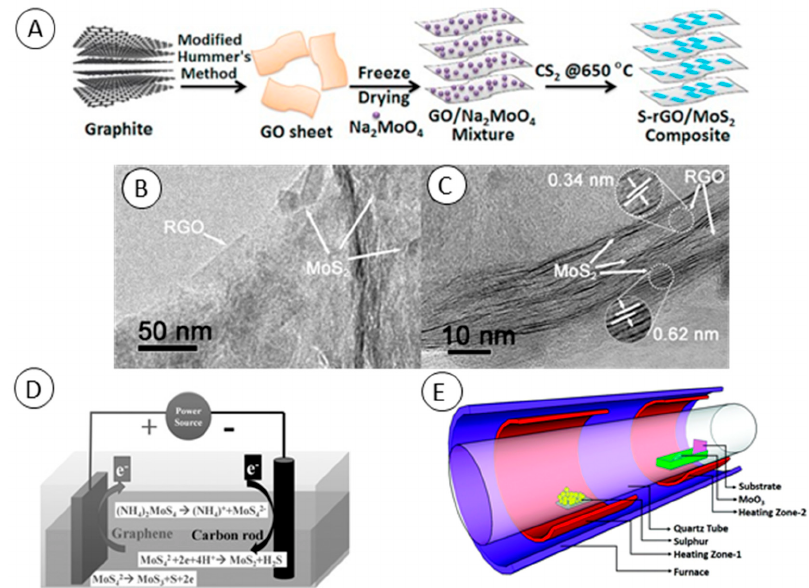
Figure 2. ( A ) Schematic representation showing synthesis of S-doped reduced graphene oxide (rGO) / MoS 2 composite. From Wang et al. [32]. ( B ) Low-magnification and ( C ) high-magnification TEM images of rGO / MoS 2 composite fabricated by one-pot microwave synthesis. From Li et al. [37]. ( D ) Schematic diagram of the chemical bath deposition of MoS 2 on graphene as the anode and carbon rod as the cathode. From Wan et al. [41]. ( E ) Schematic of the two-zone chemical vapor deposition (CVD) furnace utilized for the synthesis of vertical MoS 2 on graphene. From Gnanasekar et al.